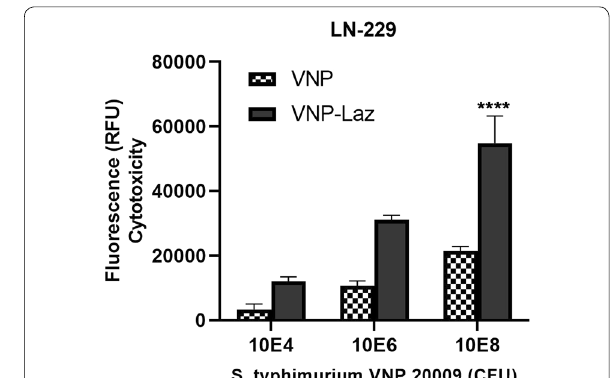
Fig. 4 Cytotoxic effect of the S . typhimurium VNP 20009 expressing Laz (VNP‑Laz) on tumor cells in vitro. Monolayers glioblastoma cell line LN‑229 (WT p53) were co‑cultured with increasing bacterial densities (10 4 , 10 6 , or 10 8 cfu) of VNP alone or VNP‑Laz under hypoxic conditions for 24 h. Apoptosis was assessed the same method of breast cancer cell line for comparison. All data are shown as mean s.e.m and represent data from three independent ± experiments n 3. *P < 0.0001 with respect to the control groups at = the same